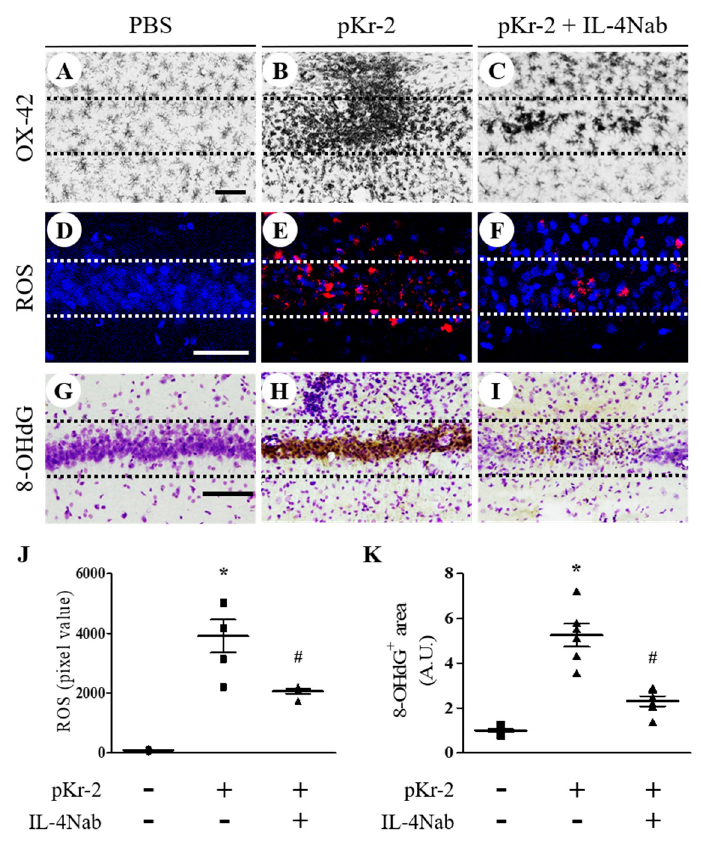
Figure 5. IL-4 induces activation of microglia/macrophages and oxidative stress in the CA1 layer of pKr-2-injected hippocampus in vivo. Sections ( A , D , G (PBS); B , E , H (pKr-2); C , F , I (pKr-2 + IL-4Nab)) adjacent to those used in Figure 4 were processed for immunohistochemical staining or hydroethidine histochemistry. ( A – C ) CA1 layer of the hippocampus stained for OX-42 antibody to identify microglia/macrophages. Scale bar, 100 μ m. ( D – F ) Hydroethidine histochemistry to detect oxidant production (ethidium fluorescence, red) in the CA1 layers of hippocampus. Nuclei were counterstained with DAPI (blue). Scale bar, 50 μ m. ( G – I ) CA1 layers of the hippocampus stained for 8-hydroxy-2-deoxy guanosine (8-OHdG) antibody to detect oxidative DNA damages and counterstained with Nissl. Scale bar, 100 μ m. ( J ) Quantification of ROS expression. * p < 0.001, significantly different from PBS (control). # p < 0.001, significantly different from pKr-2. mean ± SEM; n = 4 to 5 in each group, ANOVA and Newman–Keuls analysis. ( K ) Quantification of 8-OHdG expression. * p < 0.001, significantly different from PBS. # p < 0.001, significantly different from pKr-2. mean ± SEM; n = 4 to 5 in each group, ANOVA and Newman–Keuls analysis. Dotted lines indicate the CA1 layer of the hippocampus.